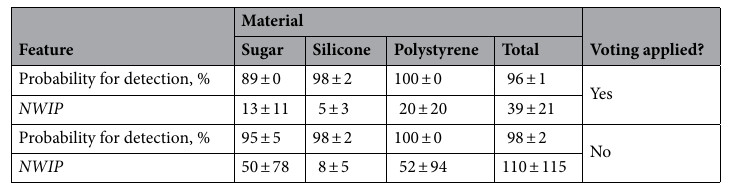
Table 1. The educated machine algorithm’s performance (run parameters: 7 iterations, p = 0.15, voting between 5 data cubes). Standard deviations were calculated by repeating the computations for n = 24.